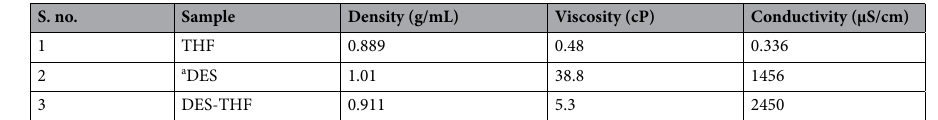
Table 4. Properties of DES system at ambient conditions. THF tetrahydrofuran. a TBAB-MEA deep eutectic solvent.